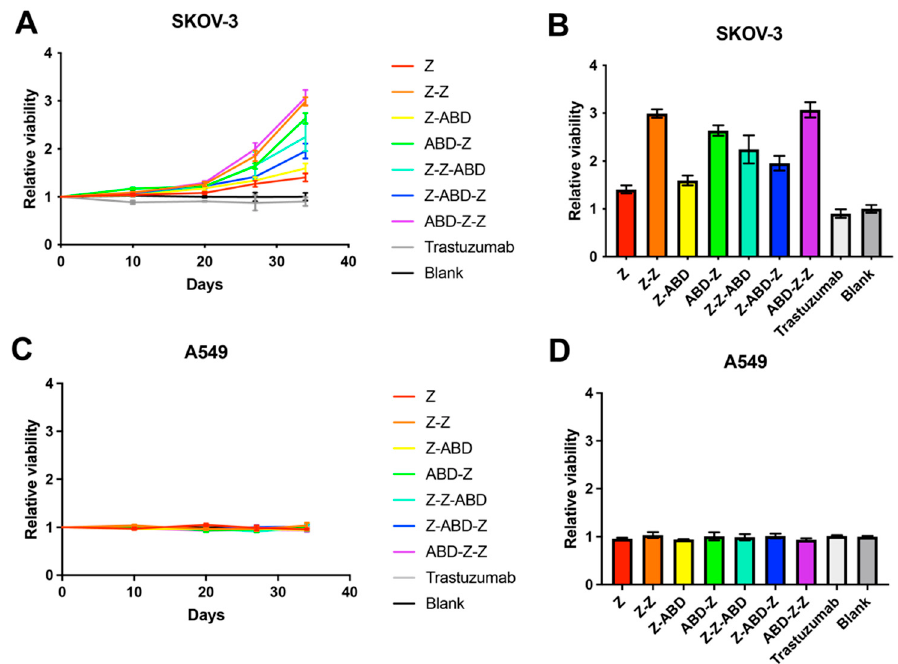
Figure 2. Effects on cell proliferation by the affibody constructs. ( A , C ) The relative viability of SKOV-3 cells ( A ) and A549 cells ( C ) was measured as a function of time. The relative viability was calculated by dividing each culture’s viability with that of the blank, where cells were grown in complete medium without the addition of any construct. ( B , D ) The columns represent the relative viability measured at day 34 for SKOV-3 cells ( B ) and A549 cells ( D ). All the data points are based on triplicate measurements and the error bars correspond to 1 SD.